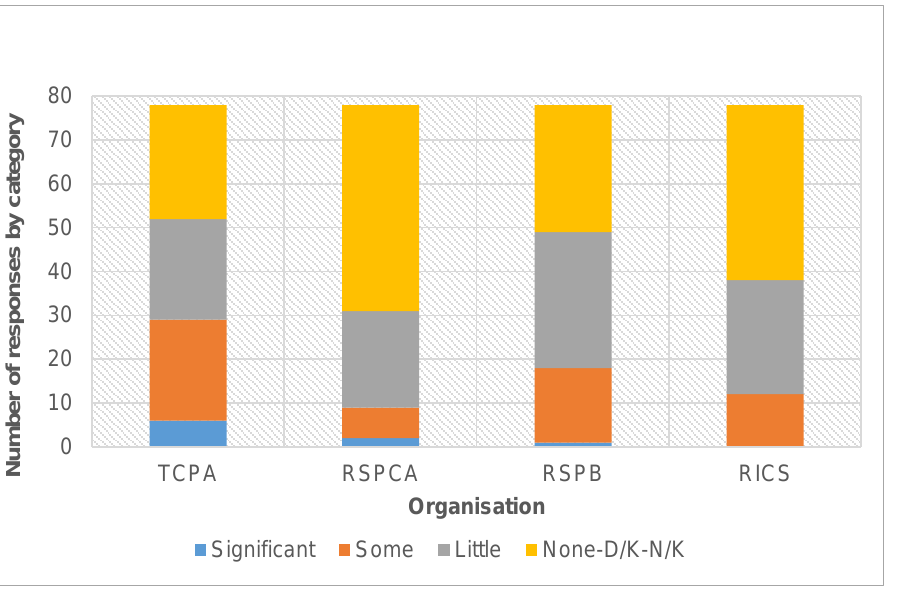
Figure 6: Participants’ assessments of loci of influence over rural policy in West Dorset ‘charities/professional